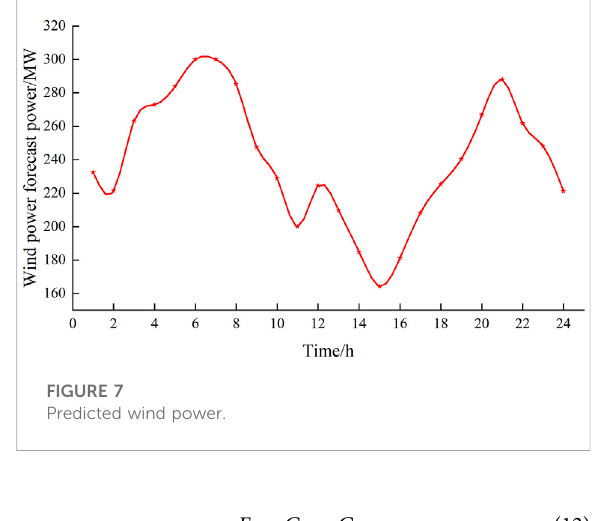
FIGURE 7 Predicted wind